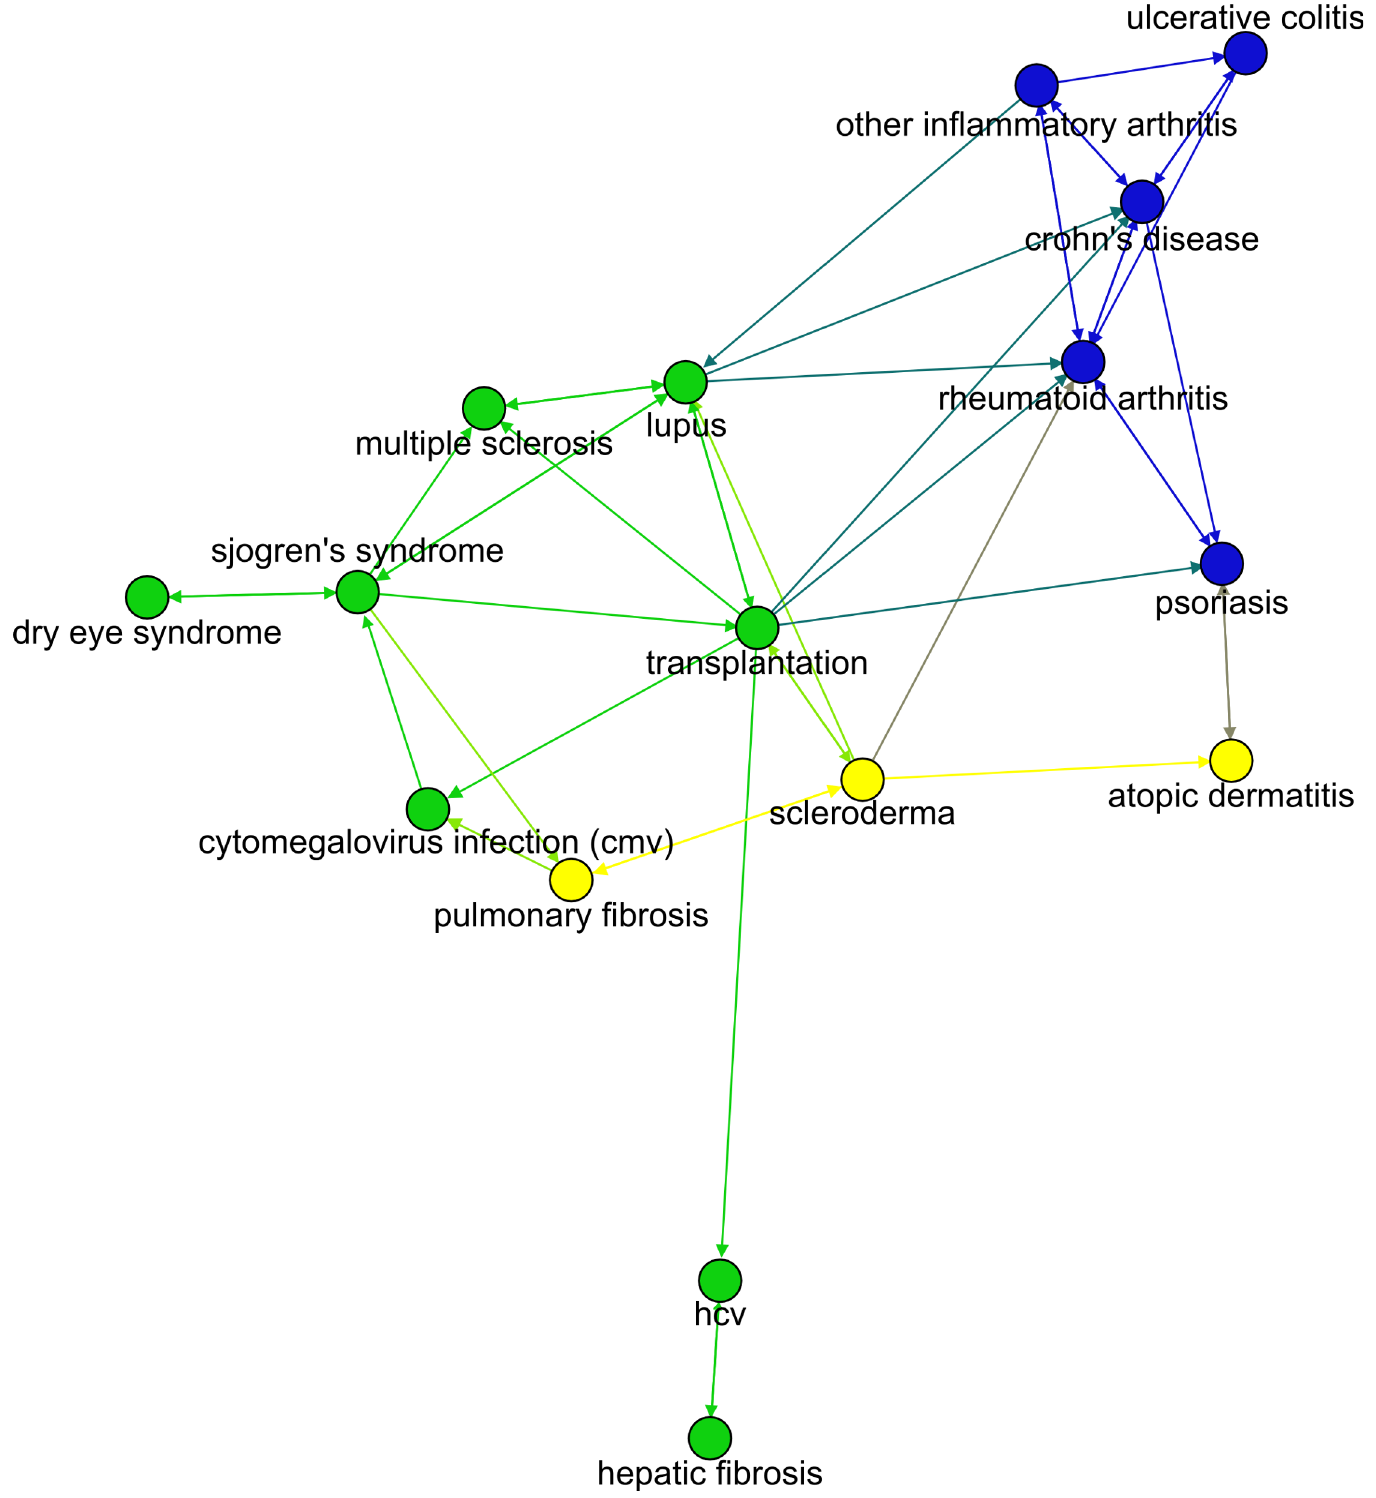
Fig 7. Autoimmune subnetwork based on the Trial dataset. Node colors reflect modularity.